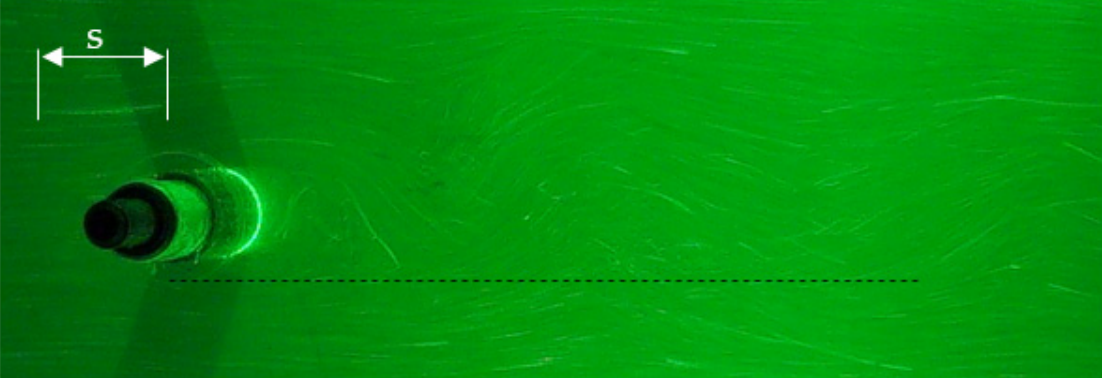
Figure 11. Image of tracer particle flow.